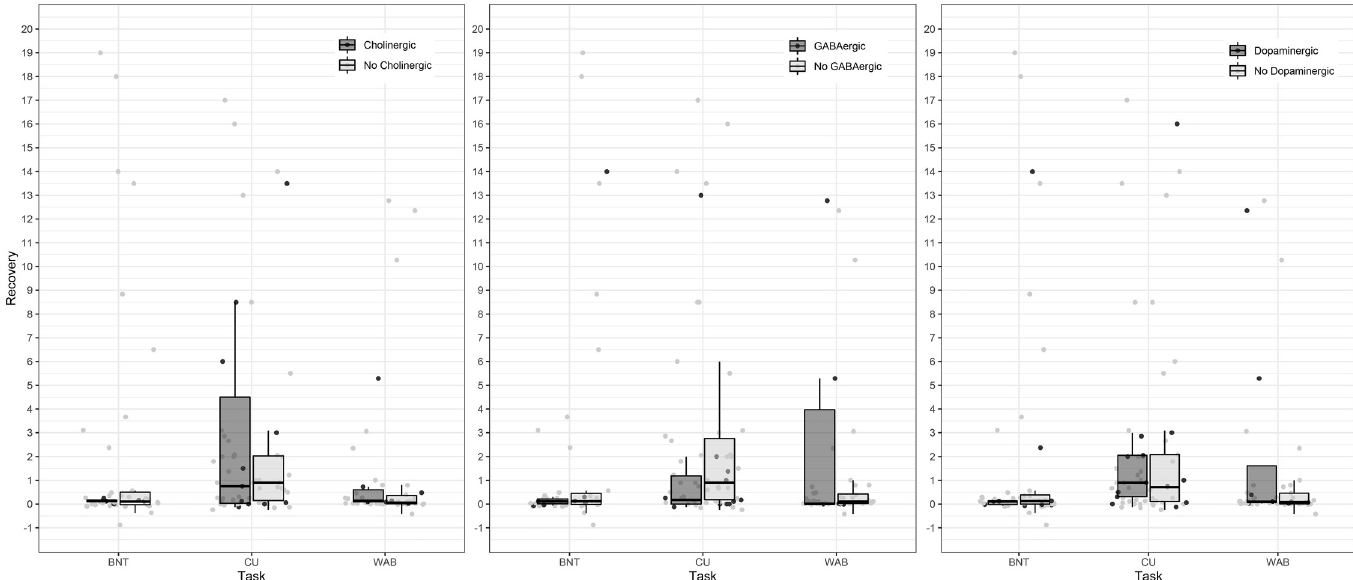
Fig 1. Change in performance by group. Scores in the table reflect standardized difference scores between acute performance and average chronic performance. In each case, the drug group is represented by the darker grey, while the no drug group is represented in lighter grey. Data points are jittered slightly on the x-axis to increase visibility of overlapping scores (within task x-axis differences are not meaningful). The outlier patient previously described with an improvement in WAB AQ of 51.5 was not included in the figure.